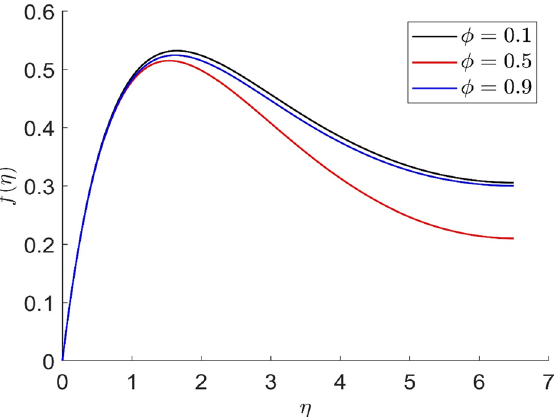
Figure 10. Representation of axial velocity f (η) for the different values of φ with R = 3, n = 3, v = 0.8, m = 3.5, Pr = 0.7, φ 1 = 0.2, φ 2 = 0.4, β 3 = 0.6, β = 0.4, β 1 = 0.3, β 2 = 0.5, u = 0.4, ξ = 0.4.